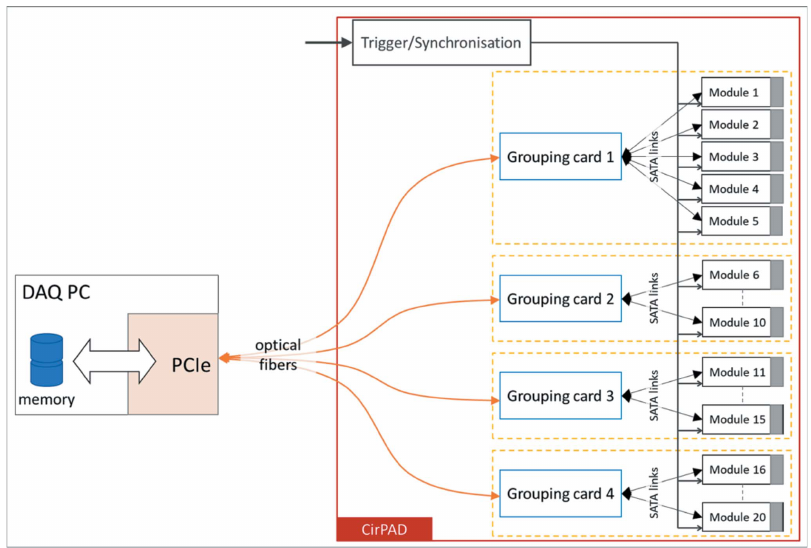
Figure 3 Readout architecture of the CirPAD.